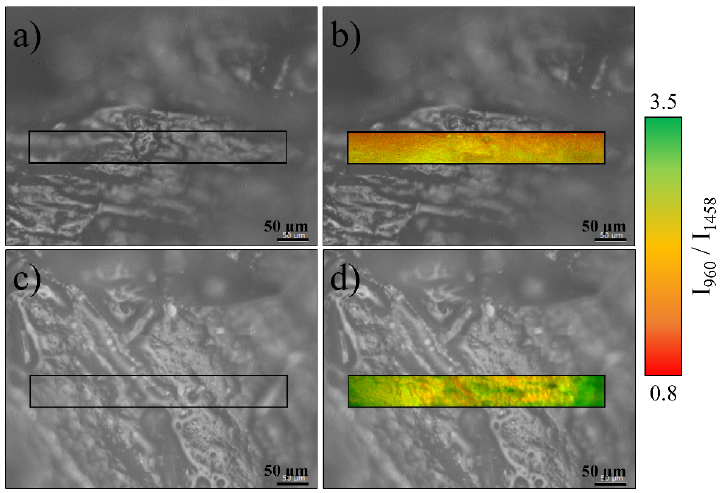
Figure 2. Optical and Raman imaging of the surface of Sample No7: ( a ) optical image of an osteonecrotic area, ( b ) Raman imaging of the same area, ( c ) optical image of a healthy area, ( d ) Raman imaging of the same area.